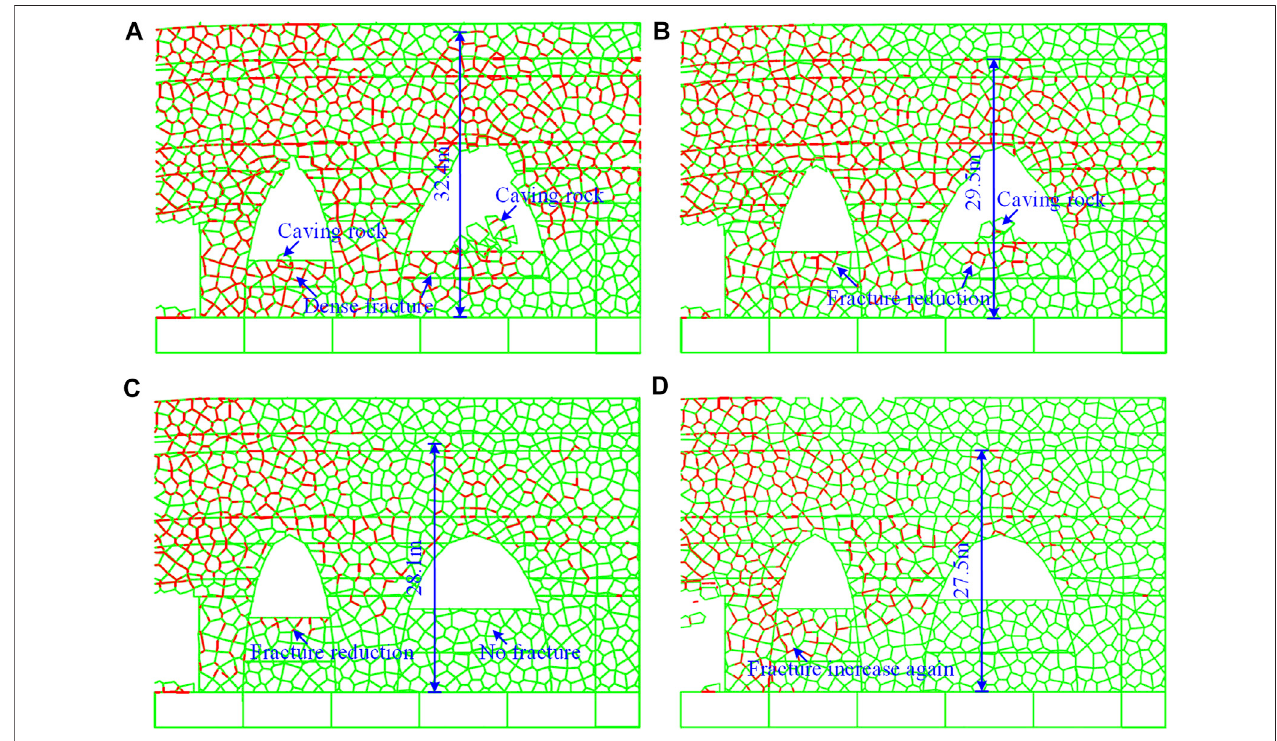
FIGURE 9 | Fracture propagation pro fi le: (A) 3 m; (B) 4 m; (C) 5 m; (D) 6 m.